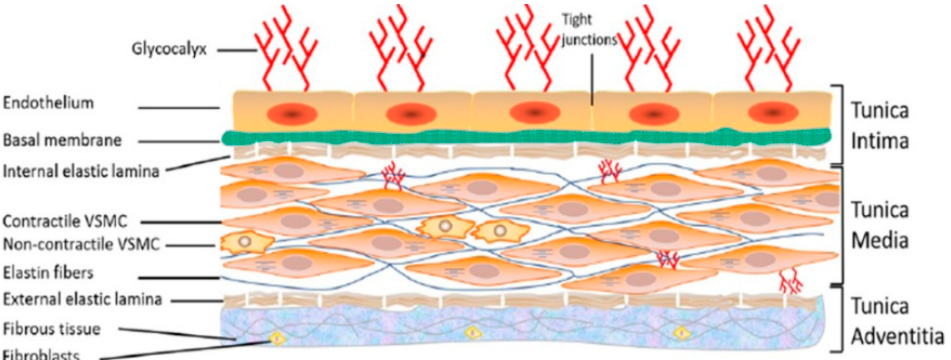
Figure 1. Structure of the vascular wall. Schematic representation showing the three layers of the vascular wall: tunica intima, tunica media, and tunica adventitia, as well as the components of each layer. VSMC: vascular smooth muscle cell. From Bkaily et al., 2021 [2].